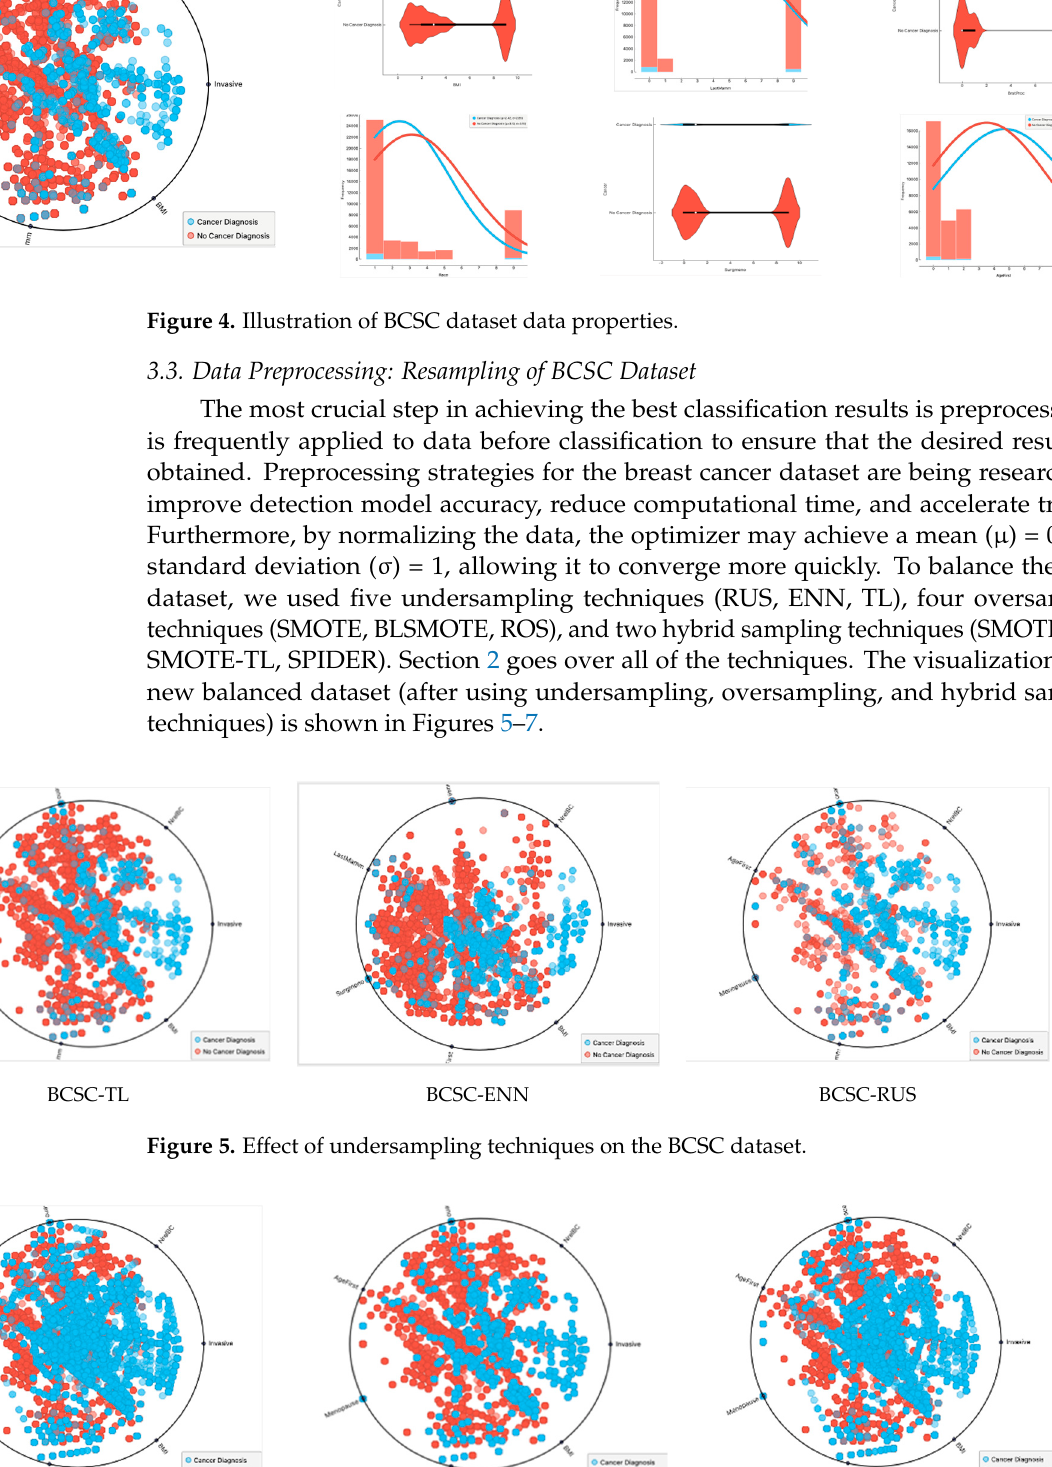
BCSC-SPIDER Figure 7. Effect of hybrid sampling techniques on the BCSC dataset. Ref. [57] discovered that the standard resampling techniques deployed in the health domain for (1) oversampling techniques are SMOTE, BLSMOTE, ESL-SMOTE, IQR- SMOTE, KMPP-SMOTE; (2) undersampling techniques are ENN and KMPP-US; and (3) hybrid sampling techniques are SMOTE-ENN, SPIDER, and AHC-OS + KM-US. Figure 8 presents the outcome of their review. Based on the result, we proposed using the above- mentioned resampling techniques in this study because, according to the literature review and to the best of our knowledge, not all of the techniques presented in this paper have been used to balance the BCSC dataset. This study will determine which resampling tech- nique improved the model’s accuracy, precision, recall, F-measure, and ROC. 3.4. Model Classification In assessing the classification accuracy of a breast cancer model, this study used sup- port vector machine (SVM) to represent classical machine learning, artificial neural net- work (ANN) to represent deep learning, and extreme gradient boosting (XGBoost) to rep- resent ensemble learning. The classifiers were chosen based on the findings of Werner et